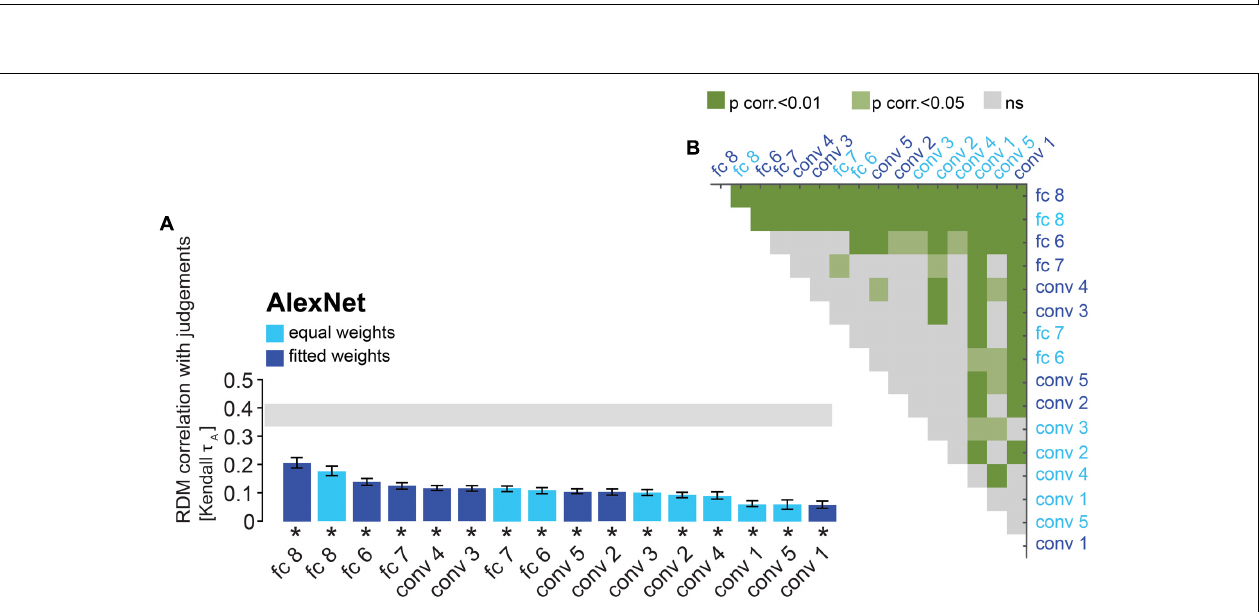
FIGURE 3 | Model predictions of the similarity judgments for each DNN layer. RDMs for each layer of each network, after weighting the feature maps (convolutional layers) or model units (fully-connected layers) within that layer to best predict the human similarity judgments. Values within each RDM were transformed into percentiles for visualization (see color bar).